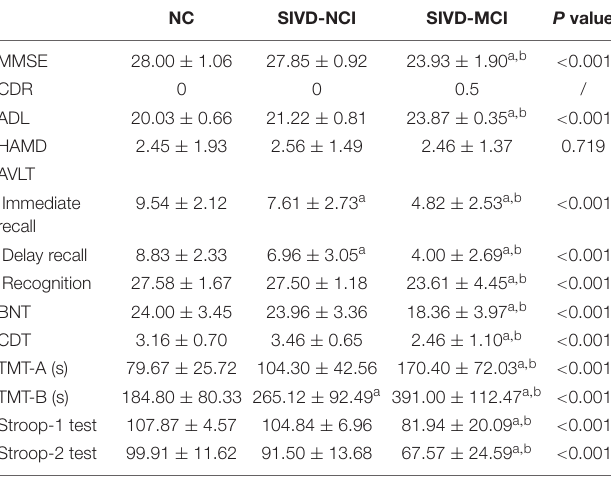
TABLE 2 | Cognitive characteristics of the participants.